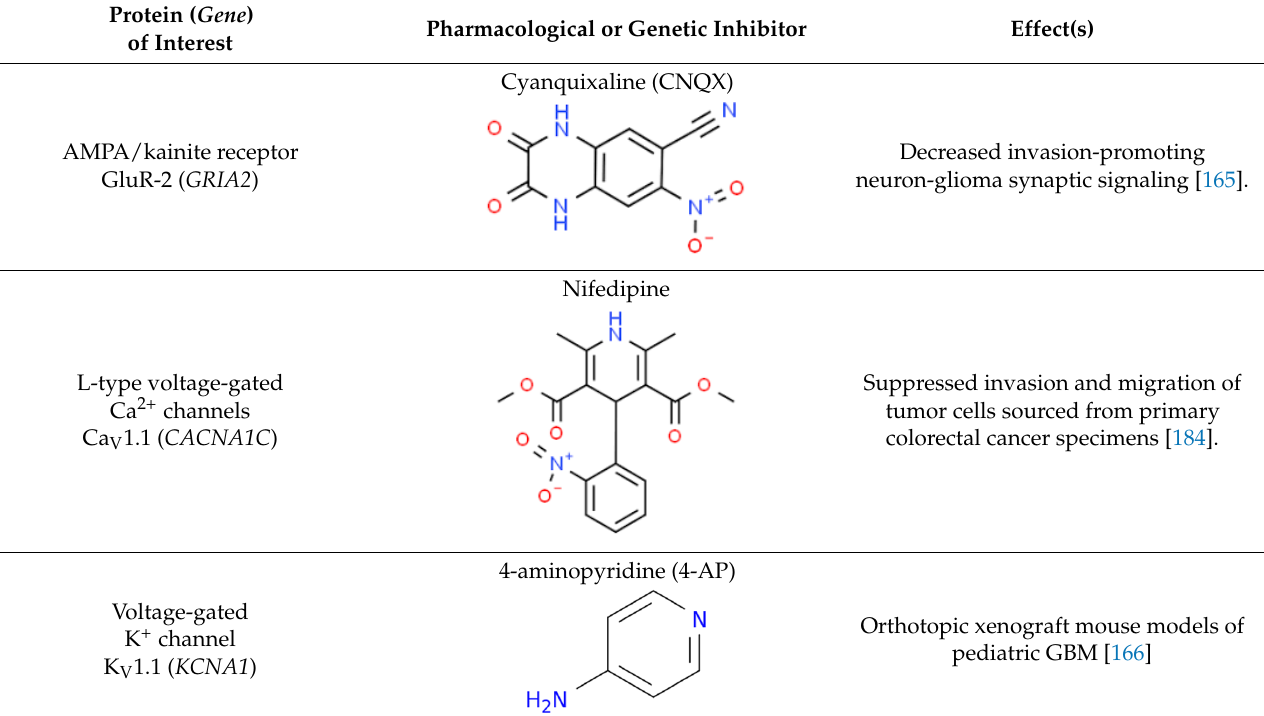
Table 3. Effects of selective ion channel inhibition on cellular motility in in vitro cancer models.